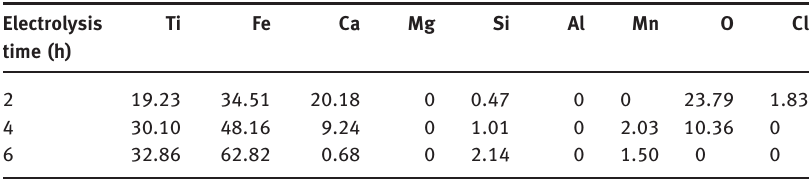
Table 2: EDX results of the electrolytic products for Fe – Ti residue pellets after different times